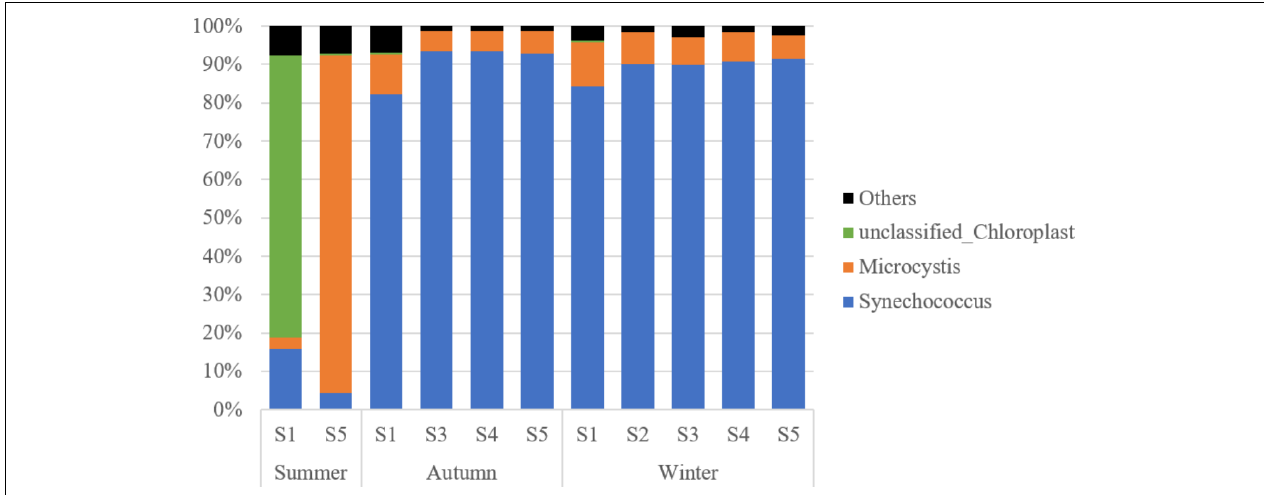
FIGURE 4 | The taxonomic composition of PE-cells from the sorted samples in Lake Fuxian.